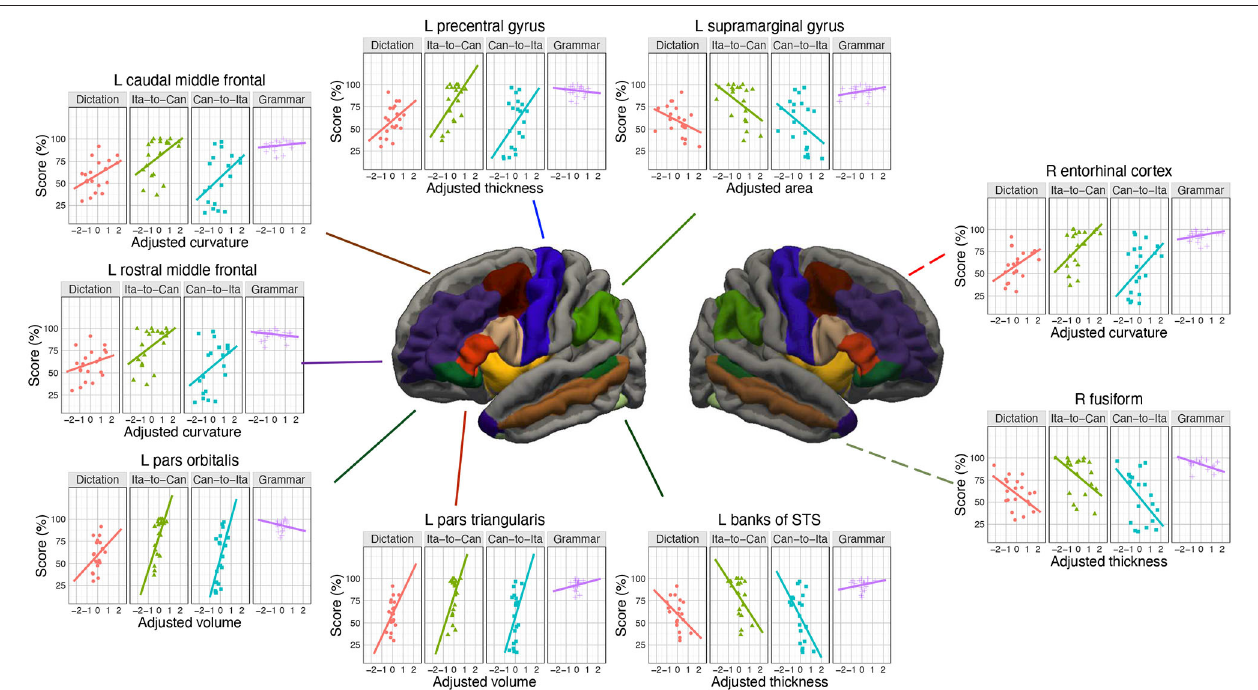
FIGURE 5 | Associations of the final test score with the cortical measures. A more left-dominant network was implicated, with seven left hemisphere regions showing significant associations with the final test score when compared to only two right hemisphere regions.